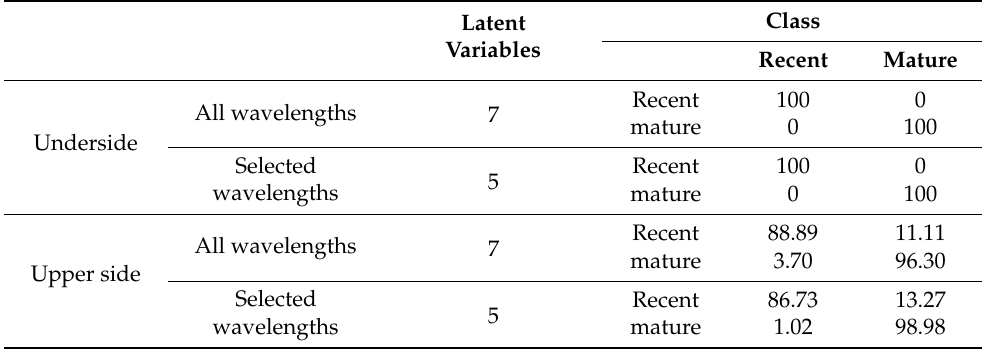
Table 5. Classification of age of T. urticae damage (%) for the validation set by PLS-DA using all and selected wavelengths on each side of the